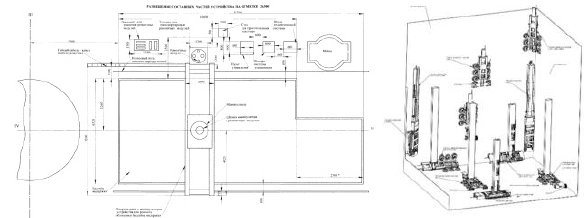
Fig. 1. Operating device position examples